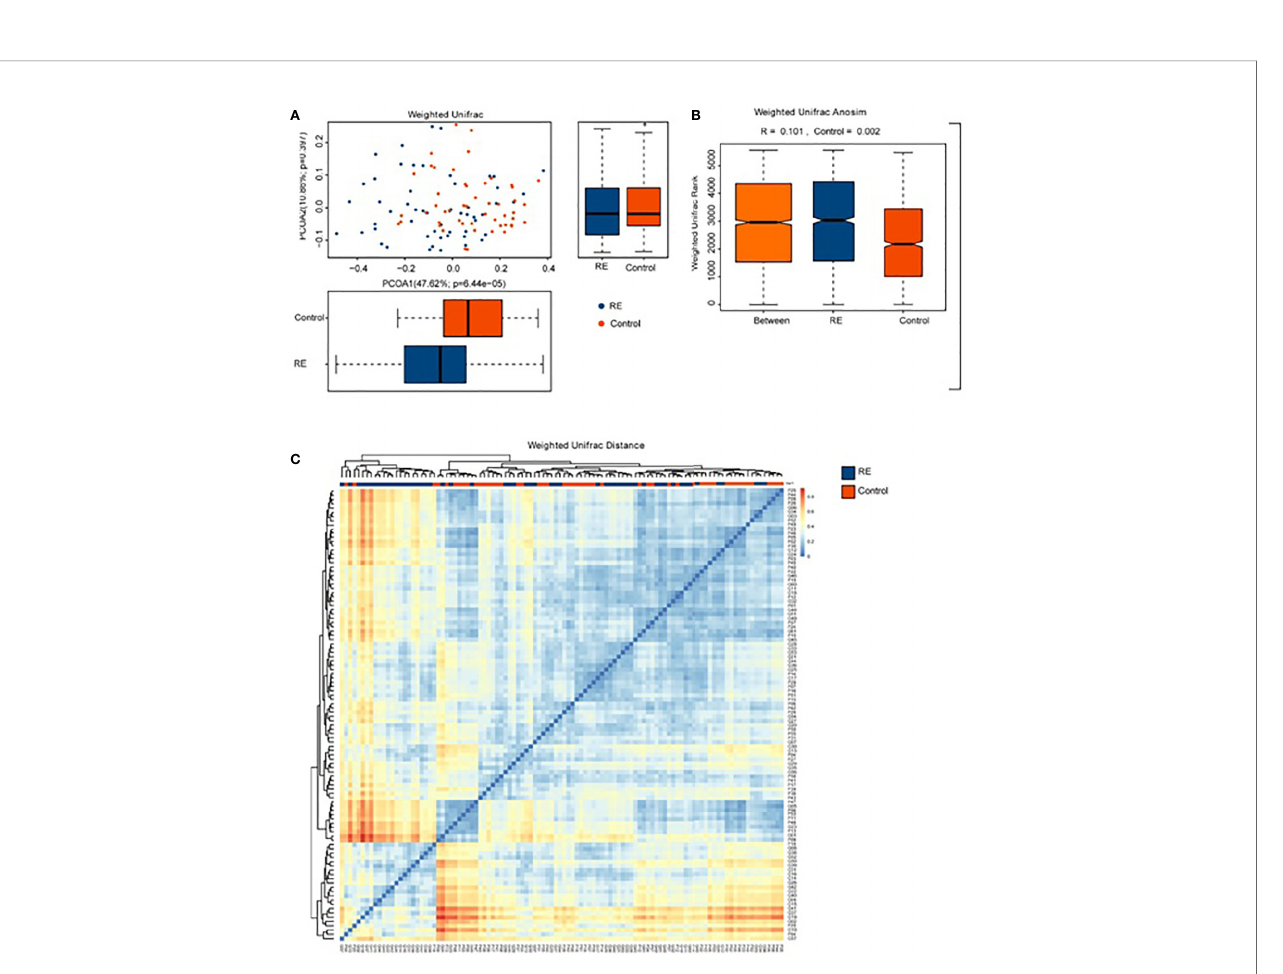
FIGURE 2 | Comparison of the oral microbiome between Re fl ux Esophagitis (RE) and healthy controls. (A) Difference of relative abundances of operational taxonomy units (OTUs) between RE groups and the controls groups was evaluated by Principal coordinates analysis (PCoA) plot by using weighted UniFrac distance. (B) One-way analysis of similarities (ANOSIM) evaluated the difference of the two groups; (C) Heatmap showing difference from Weighted UniFrac phylogenetic distance matrices in the two groups.